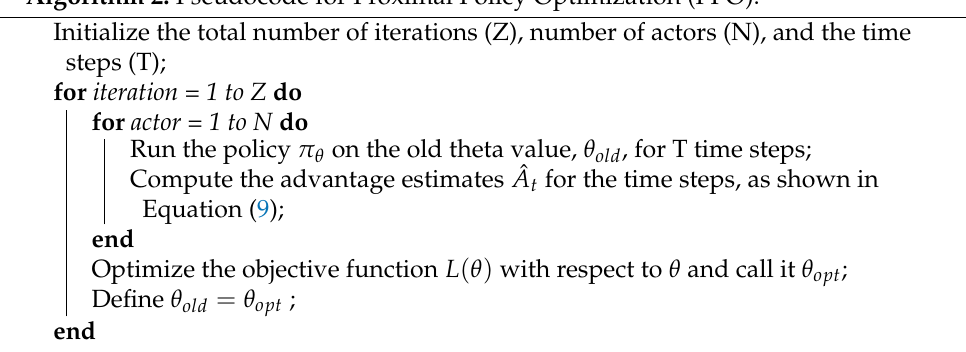
Algorithm 2: Pseudocode for Proximal Policy Optimization